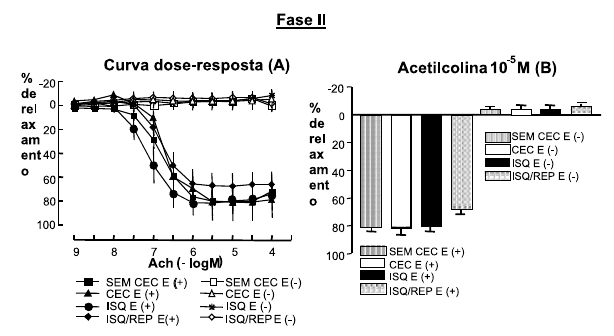
Fig. 2 - Fase II (Krebs sem magnésio): A - Curvas dose-respostas à acetilcolina (ACh) em anéis de artérias coronárias caninas, contraídas com PGF a (2 x 10 -6 M), na presença de indometacina (10 - 2 5 M); B - Efeitos da dose 10 -5 M de acetilcolina (ACh) em anéis de artérias coronárias caninas, contraídas com PGF2a (2 x 10 -6 M), na presença de indometacina (10 -5 M). (SEM CEC = grupo controle, CEC = grupo de animais submetidos a 110 min de circulação extracorpórea, ISQ = grupo de animais submetidos a 45 min de isquemia, ISQ/REP = grupo de animais submetidos a 45 min de isquemia e 60 min de reperfusão, E (+) = anéis com endotélio, E (-) = anéis sem endotélio. Valores em porcentagem de relaxamento sob a forma de médias ± erros-padrão ). (n = 6).